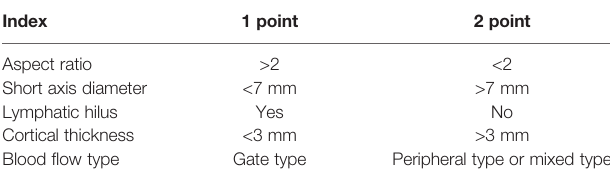
TABLE 1 | Criteria and evaluation of CUE in the diagnosis of lymph node